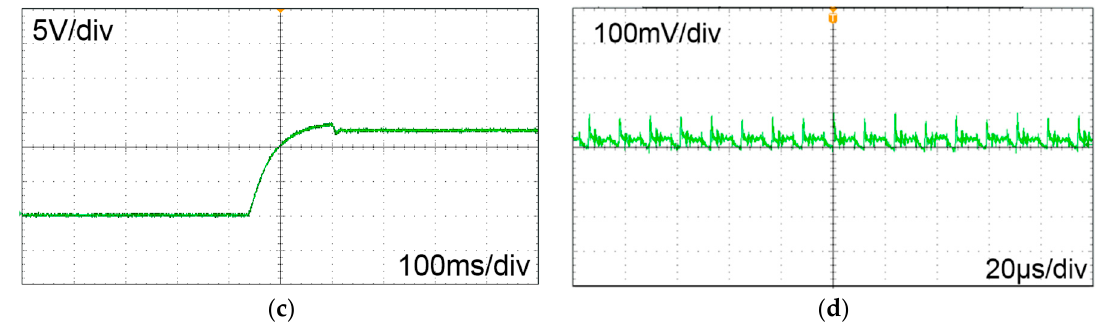
Figure 9. ( a ) The AC voltage across C 1 . ( b ) The voltage stress across the switch. ( c ) The output voltage across the load when the prototype starts up. ( d ) The ripple of the output voltage.